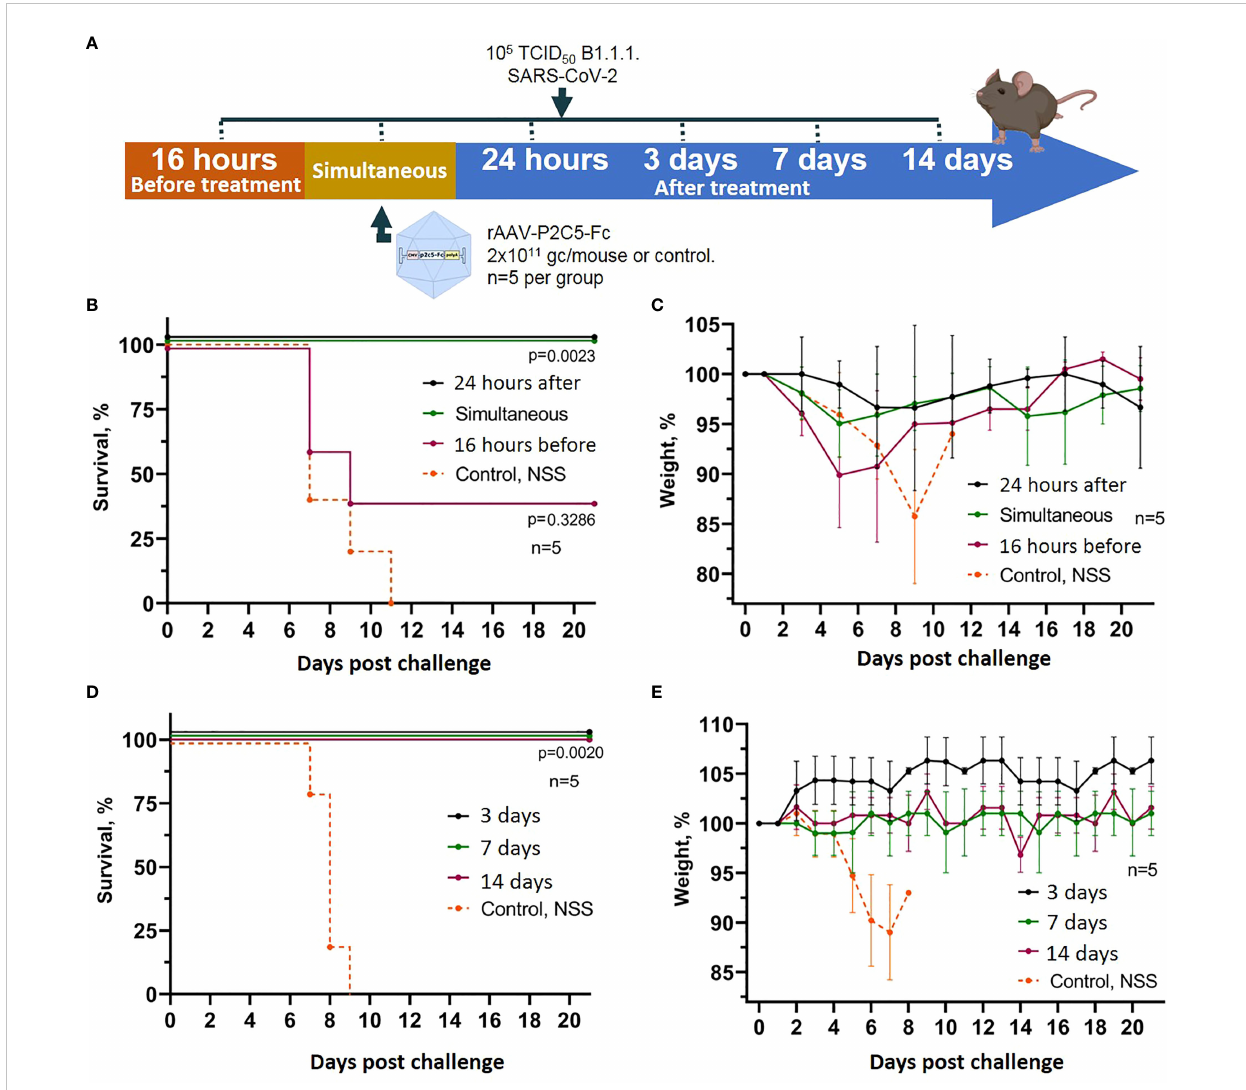
FIGURE 3 Evaluation of rAAV-P2C5-Fc ef fi cacy for early and emergency prophylaxis and prevention of SARS-CoV-2 infection. (A) Scheme of the experiment: brie fl y, mice were challenged with 10 5 TCID50 SARS-CoV-2 B.1.1.1 and treated with 2*10 11 gc/mouse of rAAV-P2C5-Fc at different time intervals. (B, C) Survival and body weight loss in emergency prophylaxis animal groups (challenge at 16 hours before, simultaneous with and 24 hours after rAAV-P2C5- Fc transduction). (D, E) Survival and body weight loss in early prophylaxis animal groups (transduction at 3,7 and 14 before the challenge). Lines – mean values, error bars – SD, numbers indicate statistical signi fi cance evaluated compared with the vehicle group using a logrank test. Data from different rAAV-P2C5-Fc treatment groups are shown by color. Control, NSS – mice received normal saline solution. n – number of animals per